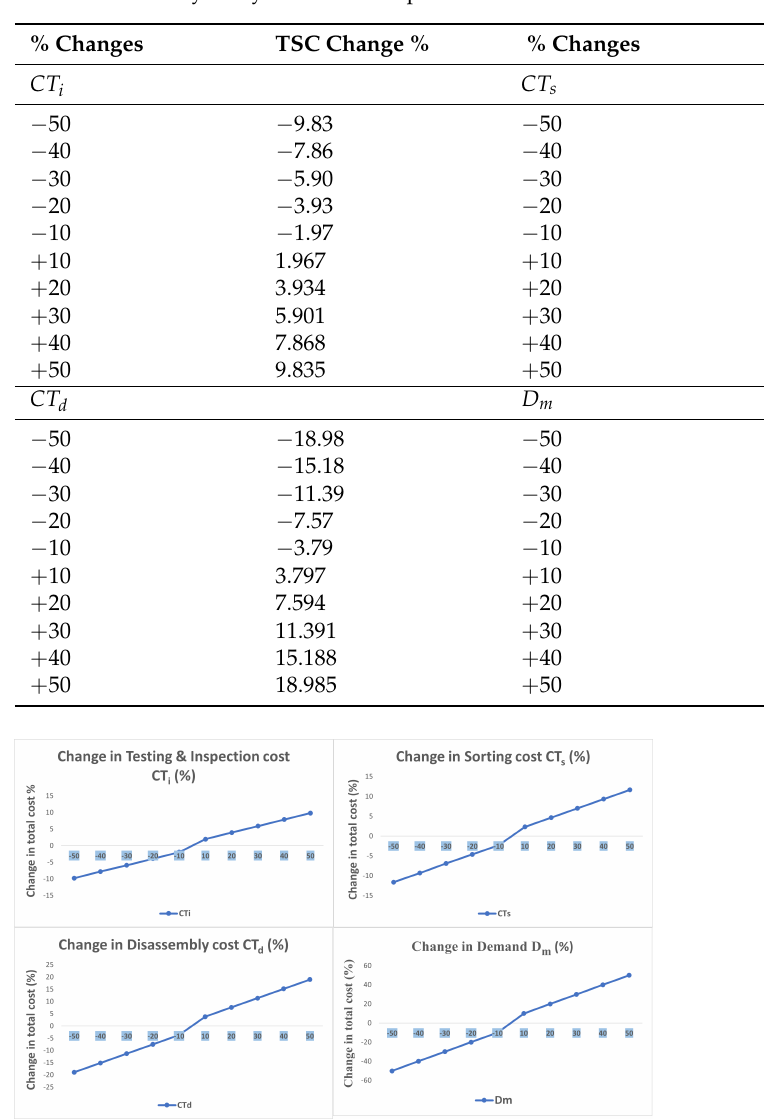
Table 3. Sensitivity analysis of relevant parameters